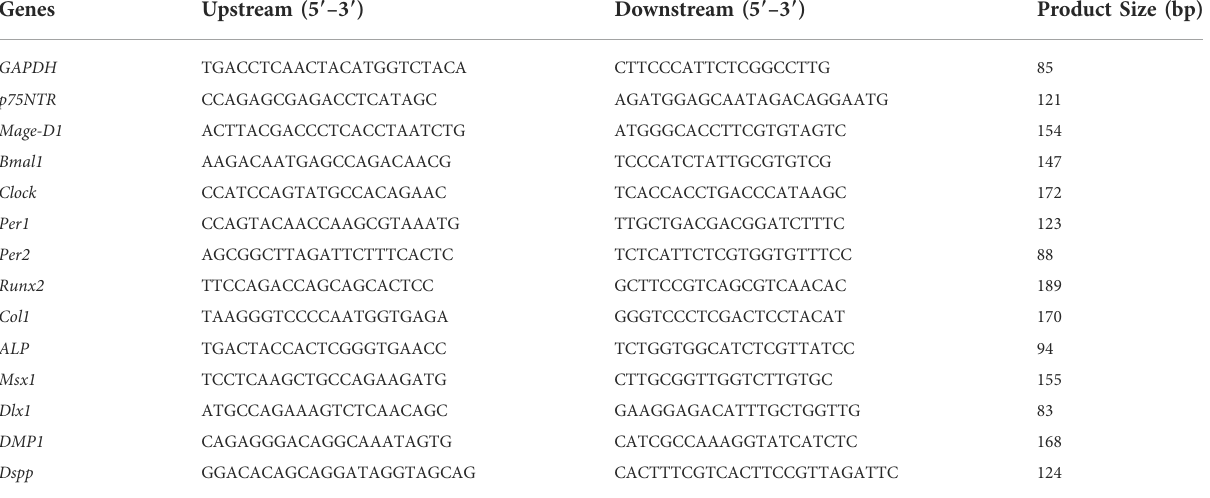
TABLE 2 Mice oligonucleotide primers used in this